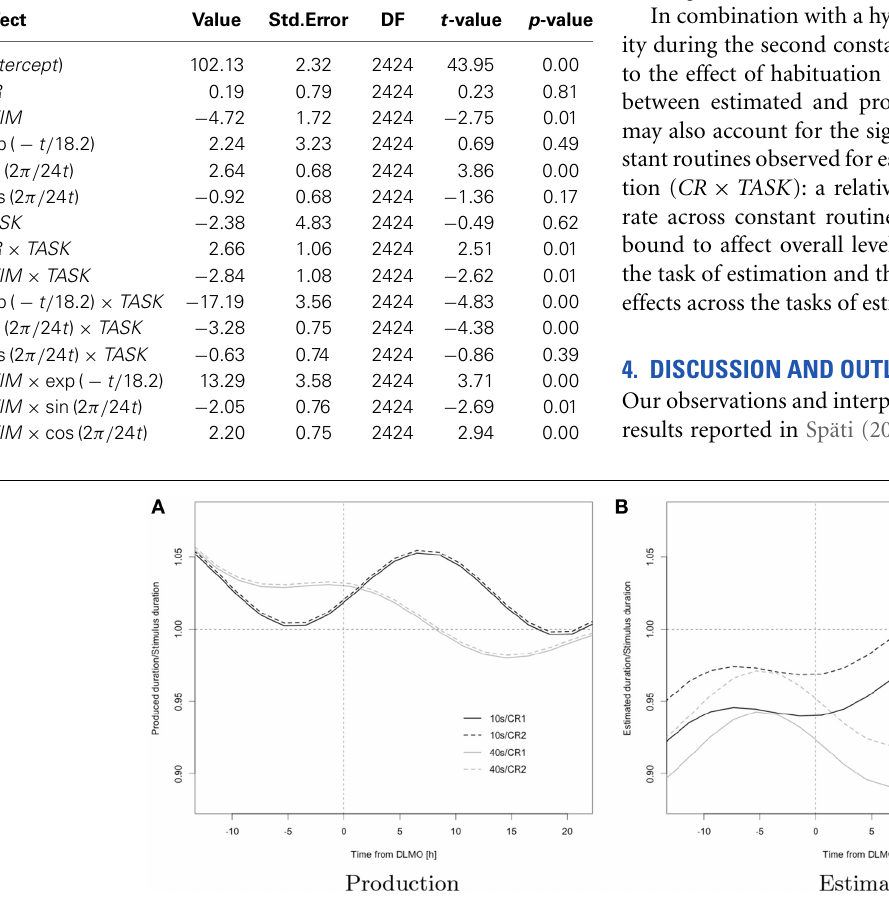
Table 1 | Estimated coefficient by model term.